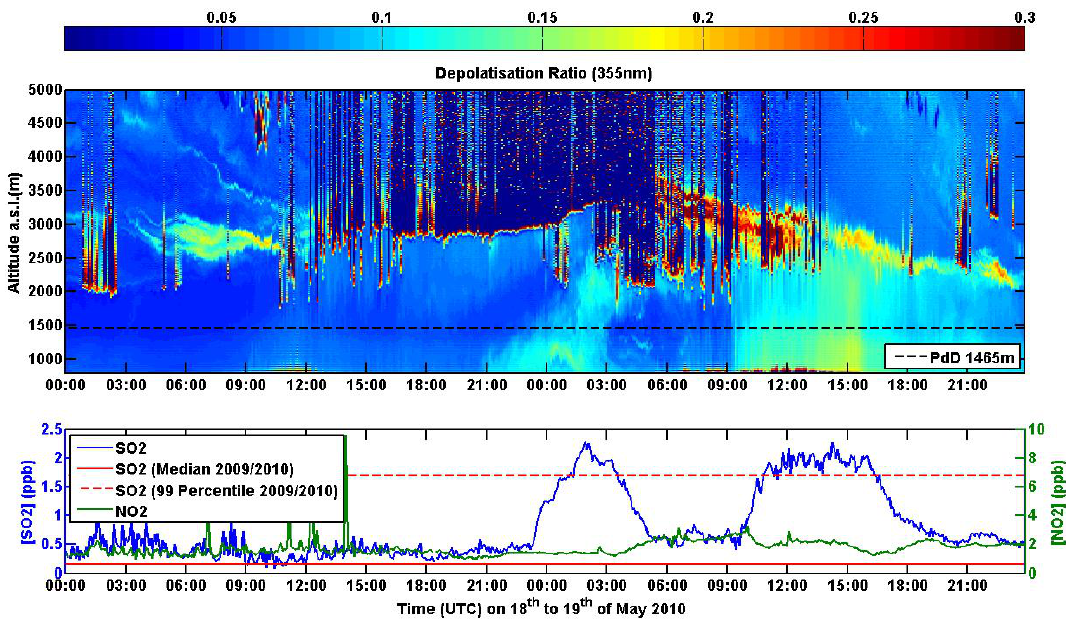
Fig. 2. Top panel: time series of volume depolarization ratio derived from the Lidar data. The black dashed line represents the height of the Puy de Dˆome measurement station (1465ma.s.l.). Bottom: SO 2 and NO 2 concentrations at PdD for the same period. The red dash line indicates the 99-percentile of SO 2 concentrations observed in 2009 and 2010 and the continuous red line the